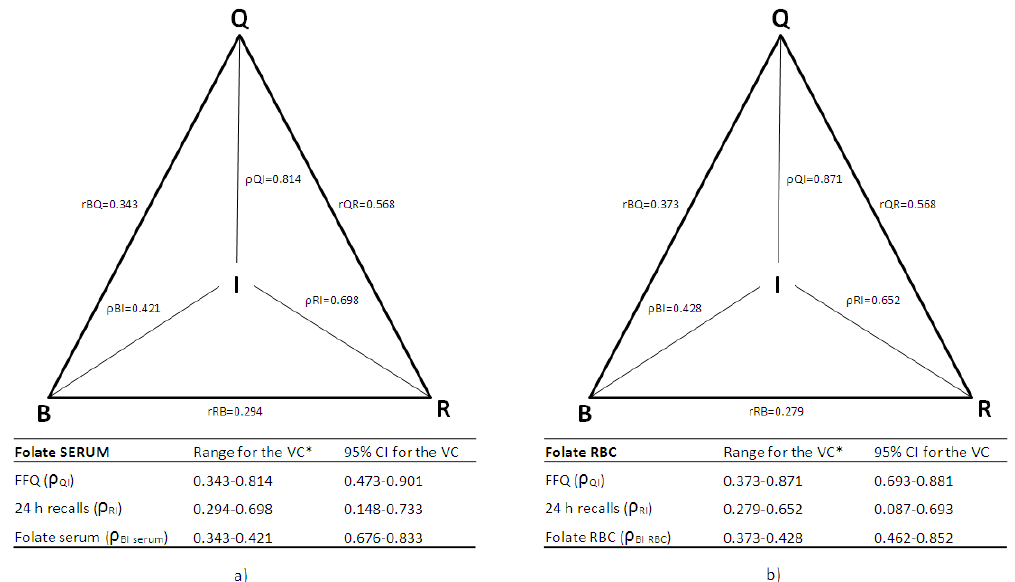
Figure 4. Triangular relationship of the correlation coefficients (r QB , r RB , r QR ) between folate intake estimated by the FFQ (Q), the average of the three 24 h dietary recalls (R) and the biomarkers (B) of folate status: ( a ) folate concentration in serum; and ( b ) red blood cells (RBC) folate concentration, and validity coefficients (VC: ρ QI , ρ BI , ρ RI) between true intake (I) and estimated intakes, with 95% confidence intervals. * The lower limit of the true validity coefficient is correlation between the biomarker and the two dietary methods (F-FFQ and 24 h recalls), and the upper limit is calculated by the method of